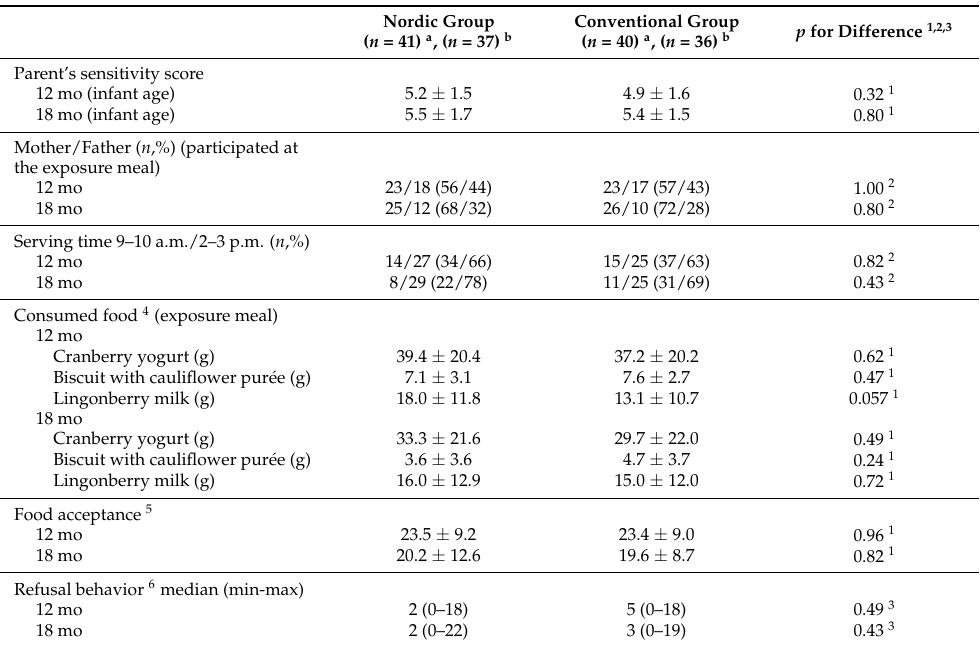
Table 7. Results from the home exposure meal at 12 and 18 mo of